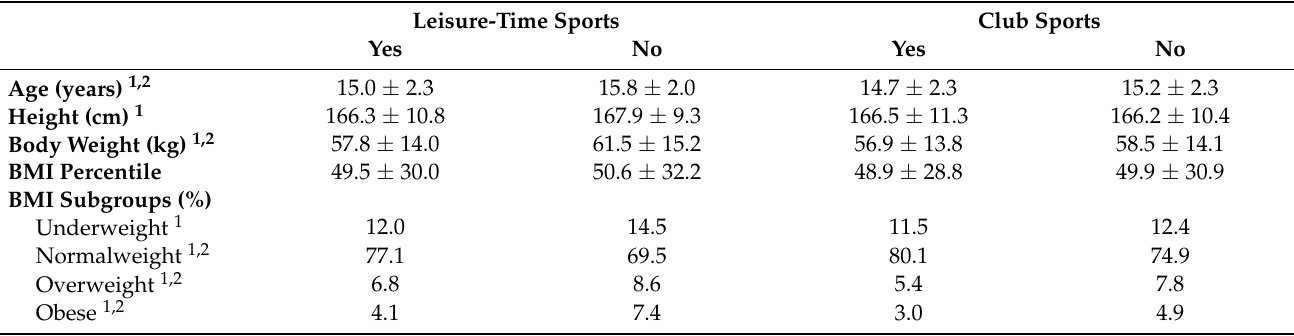
Table 4. Anthropometric characteristics by sports participation. Values are presented as means ± SD for the first four vari- ables and prevalence for BMI